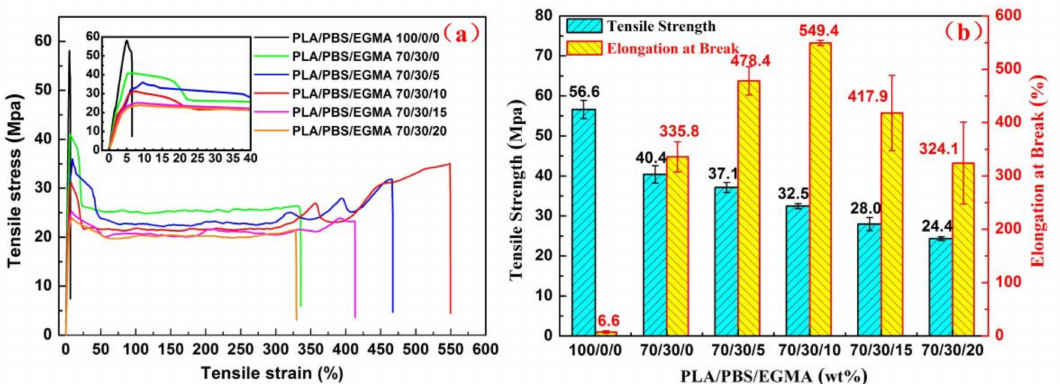
Figure 3. The tensile properties of neat PLA, PLA/PBS and PLA/PBS/EGMA blends: ( a ) strain–stress curves; ( b ) tensile strength and elongation at break.